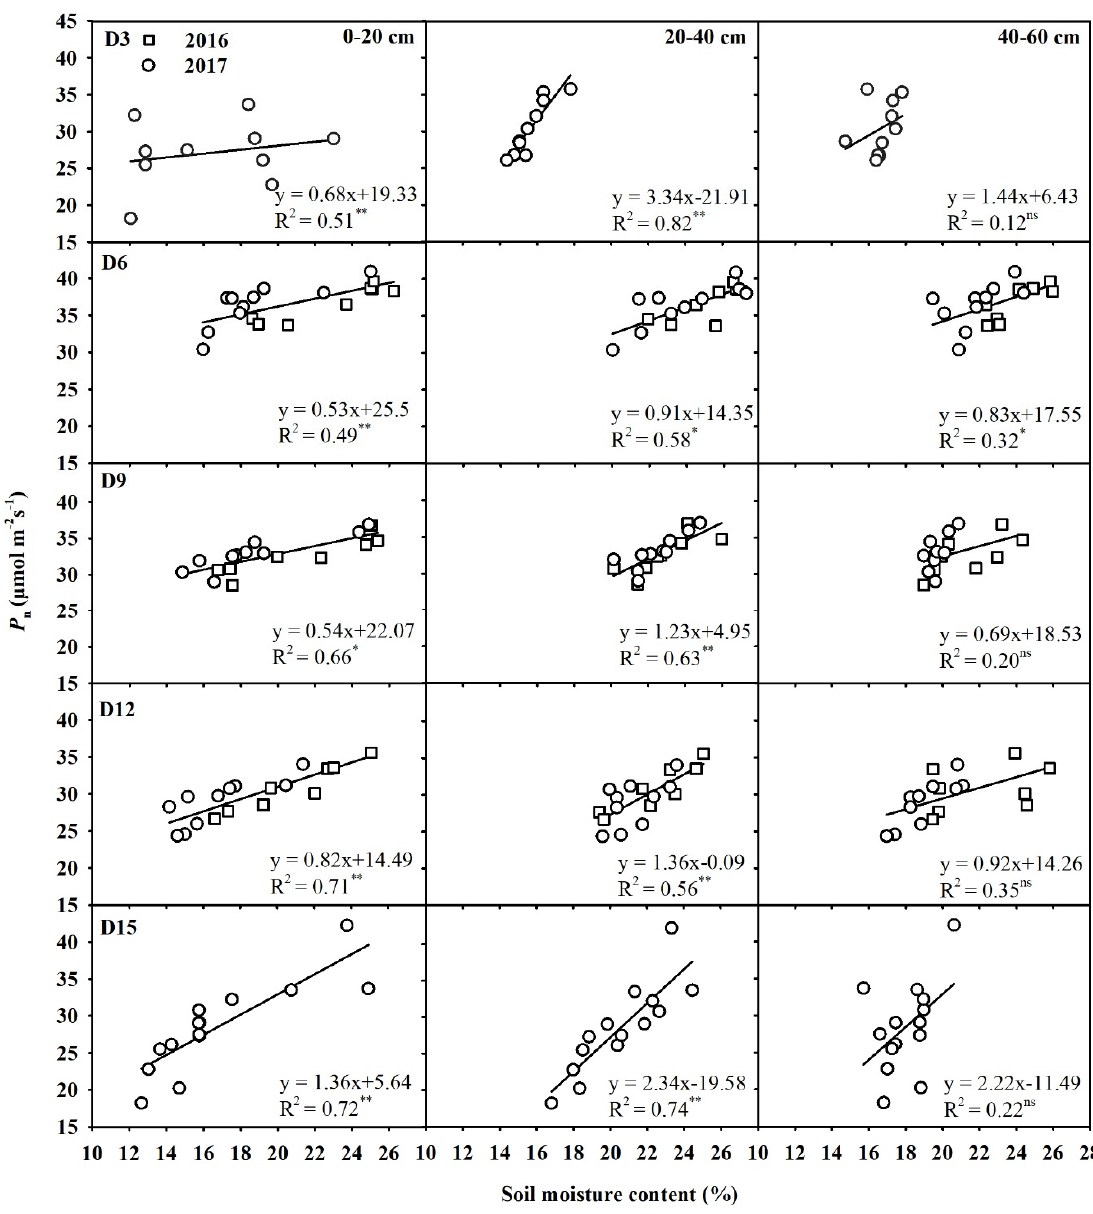
Figure 5. Relationship between soil moisture content and leaf photosynthetic rate in di ff erent soil layers at di ff erent irrigation intervals. * significant at 0.05 level; ** significant at 0.01 level; ns—not significant